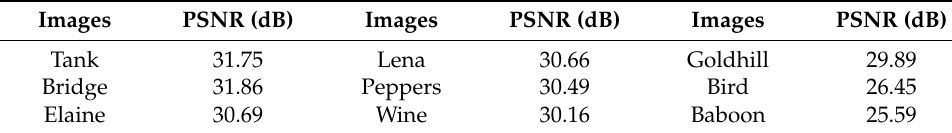
Table 1. PSNR values of the VQ images produced with our codebook.